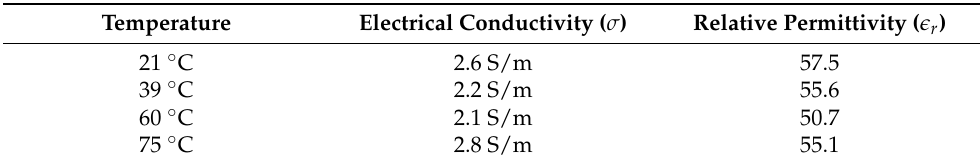
Table 2. Temperature-dependent material properties of SP at 2.45 GHz.